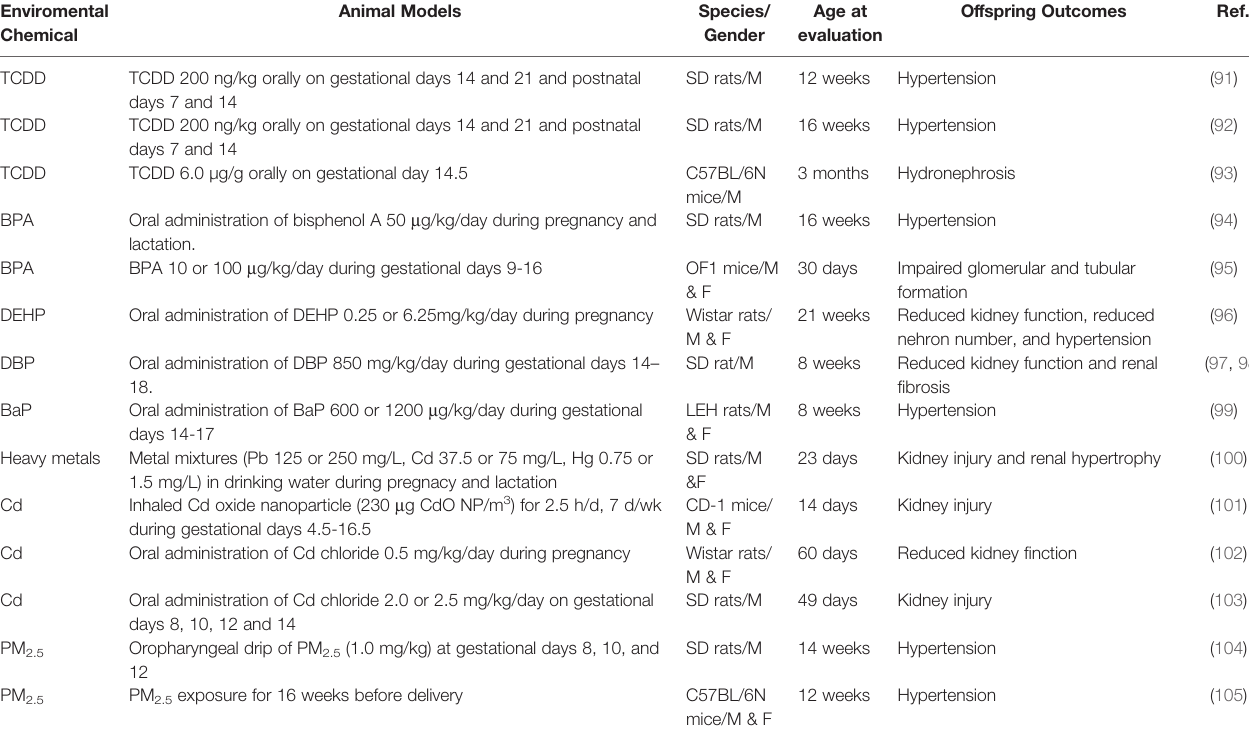
TABLE 3 | Summary of animal models of developmental programming of kidney disease and hypertension categorized according to environmental chemical exposures. Enviromental Animal Chemical